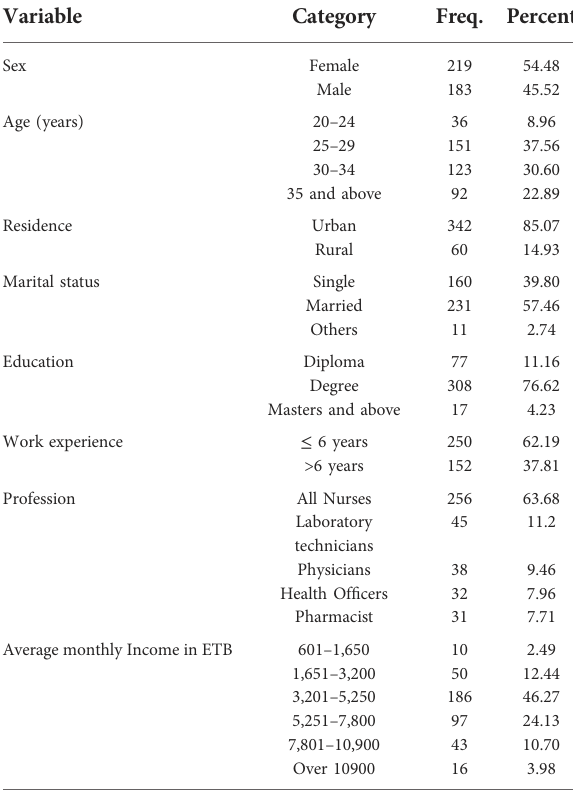
TABLE 2 Accessibility, functional status, and computer skills of healthcare professionals, Dire Dawa ( n =402).